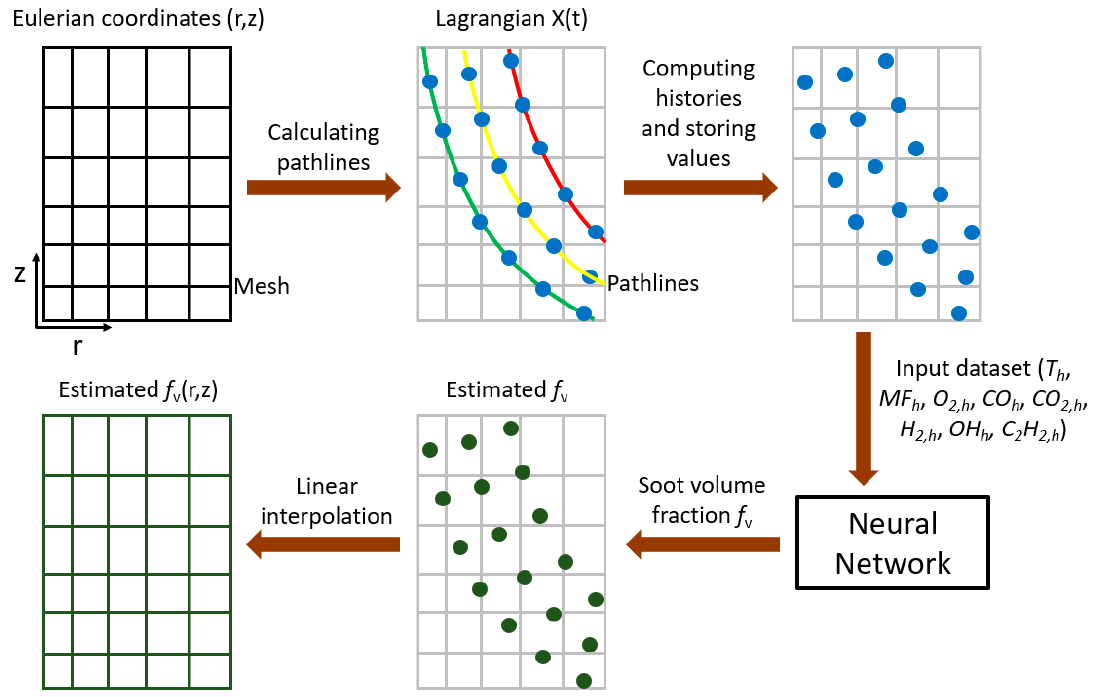
Figure 6. A schematic representation of the ANN-based soot estimator approach.